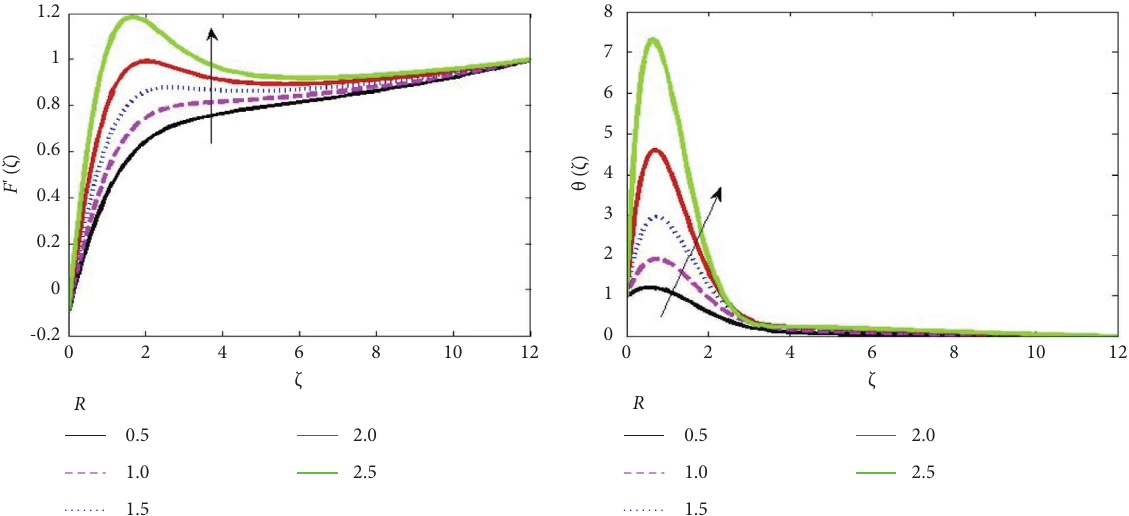
Figure 13: Efect of the thermal radiation parameter on the velocity and temperature distributions.